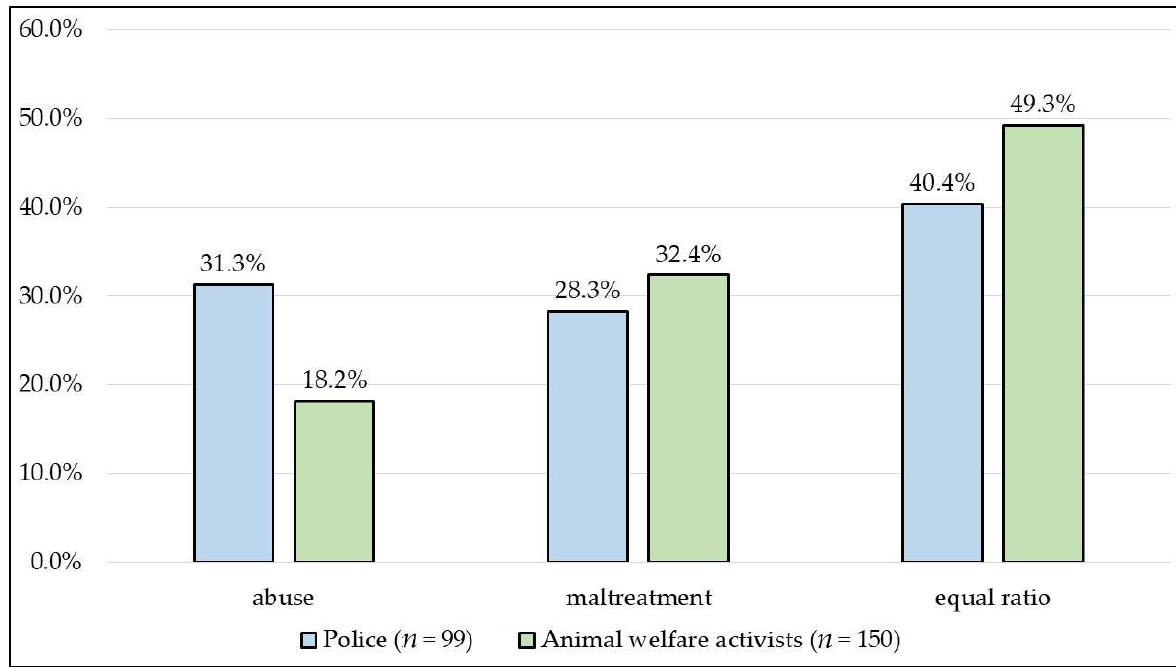
Figure 4. Which form of animal cruelty is more difficult to investigate?